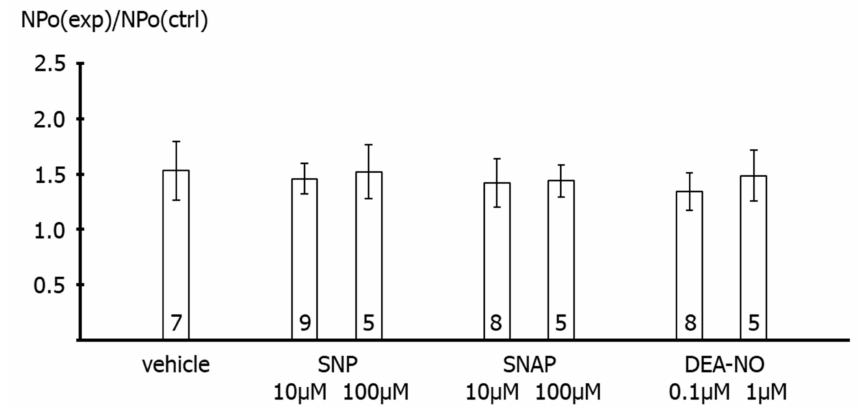
Figure 7. Effect of NO-donors on excised BK channels of rat tail artery smooth muscle cells. Data are expressed as the ratio of BK channel activity (NPo) at the end of the application period under specified experimental conditions (NPo(exp)), i.e., application of experimental bath solution in the time control series (vehicle), SNP, SNAP and DEA-NO, to BK channel activity before the beginning of the application period under the same conditions (NPo(ctrl)); number of cells investigated appears on bar for each